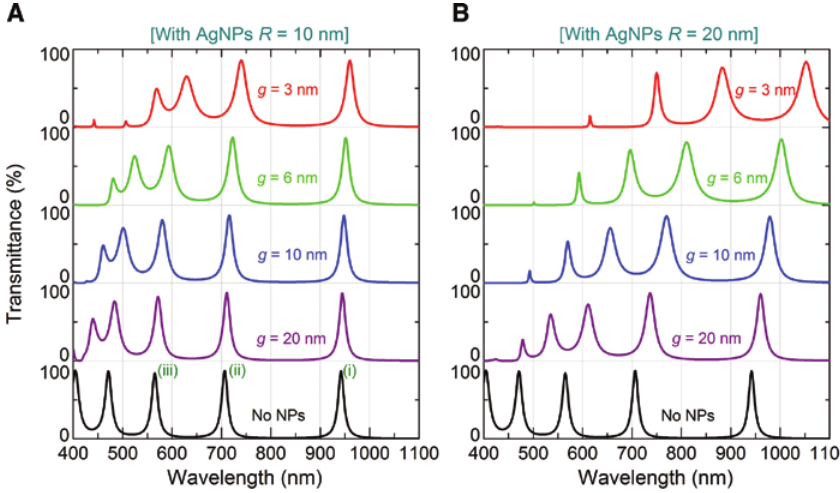
Figure 5: Tunable transmission from FPI